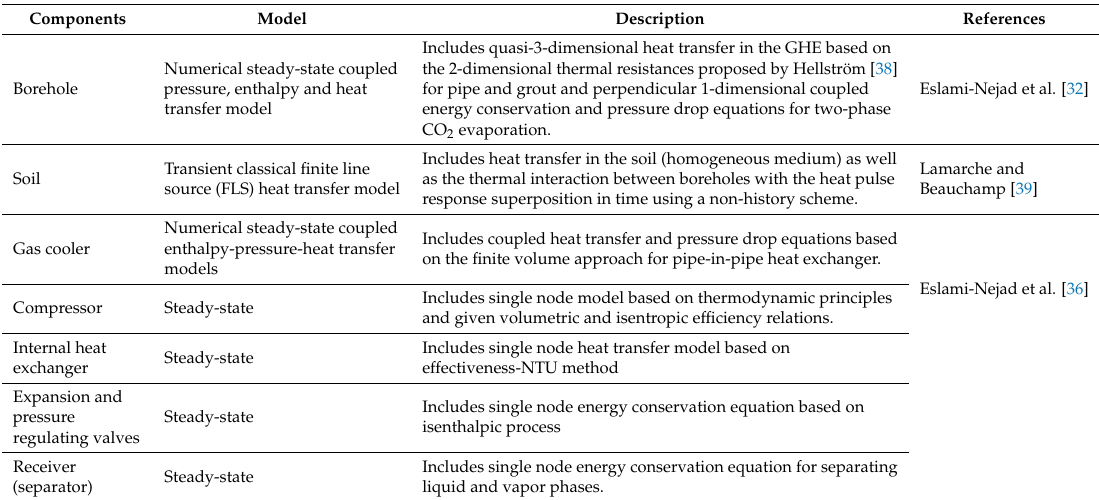
Table 4. Summary of the theoretical